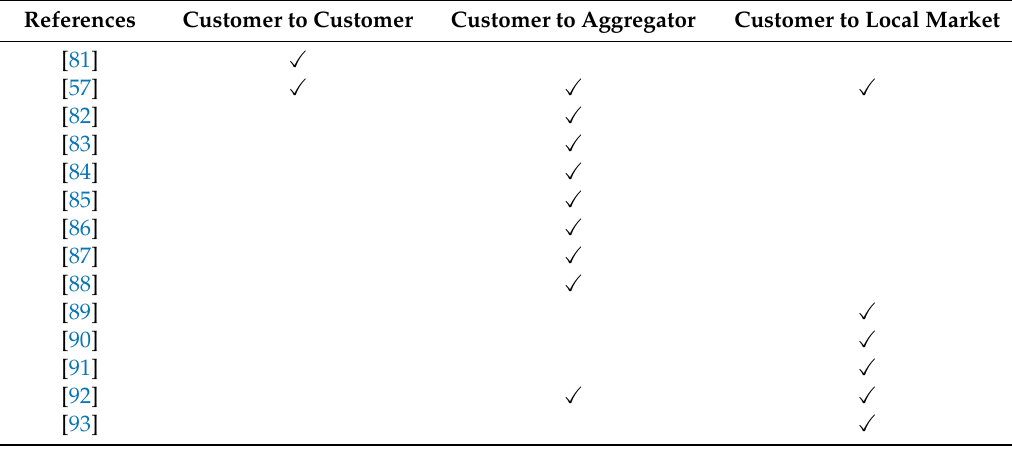
Table 2. Flexibility-related trading models at the customer